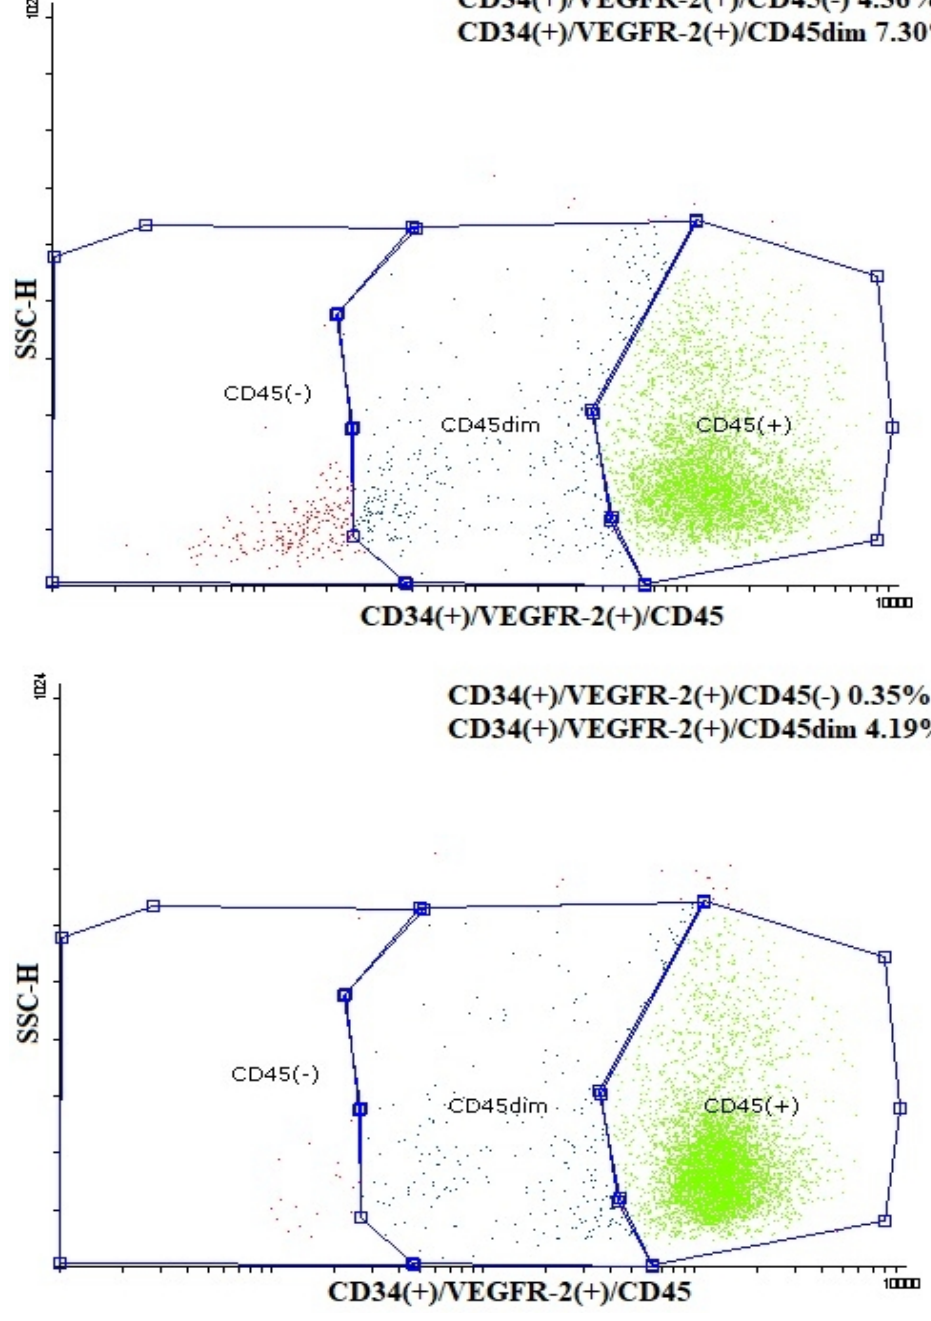
Figure 3. Representative dot plots of flow cytometric determination of CD34(+)/VEGFR-2(+)/CD45(-) and CD34(+)/VEGFR-2(+)/CD45dim endothelial progenitor cells (EPCs) in a child born prematurely ( up ) and in a child born at term ( down ). SSC-H: side scatter height. In the total study population, irisin levels were negatively correlated with the age of participants (r s = − 0.19, p = 0.03), while they were positively correlated with gestational age (r s = 0.20, p = 0.02) and birth weight (r s = 0.23, p = 0.01). Furthermore, irisin correlated positively with WHR in the total study population (r s = 0.19, p = 0.03) and in the preterm group (r s = 0.35, p = 0.01). No significant correlations were found between irisin and glucose, insulin, or lipid levels, HOMA-IR, or physical activity score in preterm-born children and